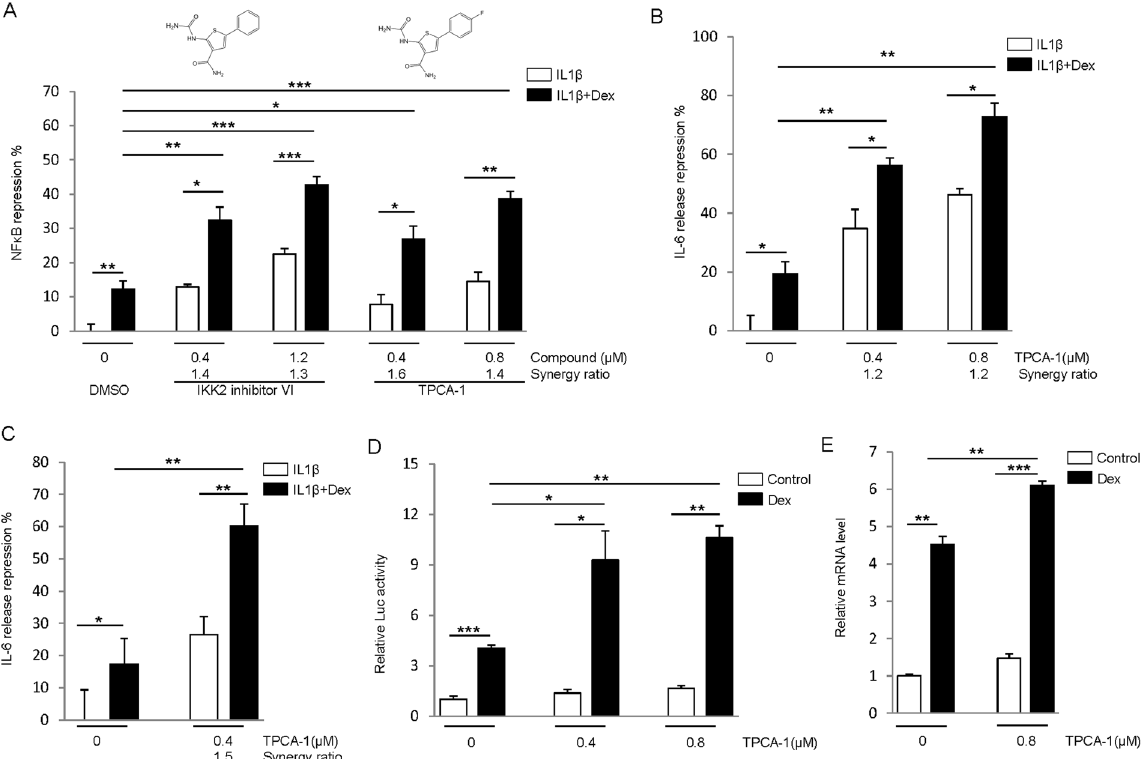
Figure 3. IKK2 inhibitors enhance GR activity. ( A ) IKK2 inhibitors enhance NF- κ B repression by GR. The reporter cells were treated with 5 ng/mL IL-1 β ± 0.5 nM Dex, and inhibitors as indicated for 18 h.